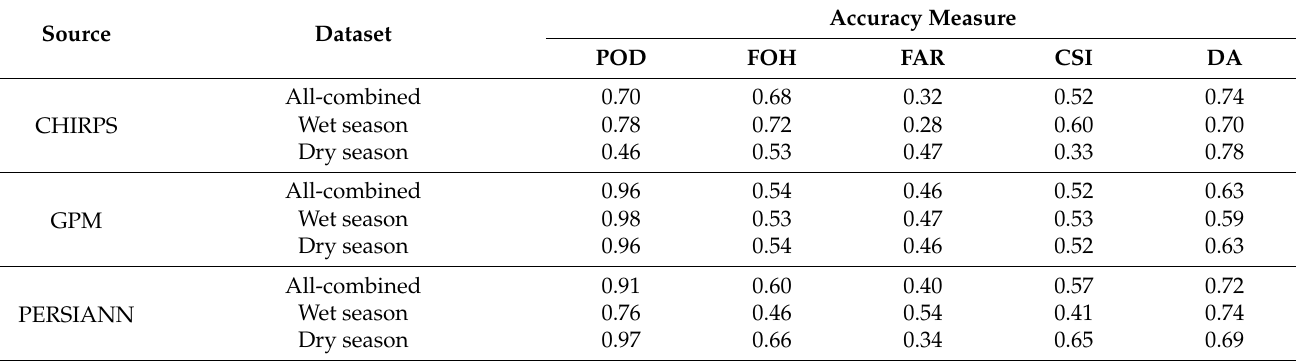
Table 6. Categorical accuracy measures of three satellite products. Source